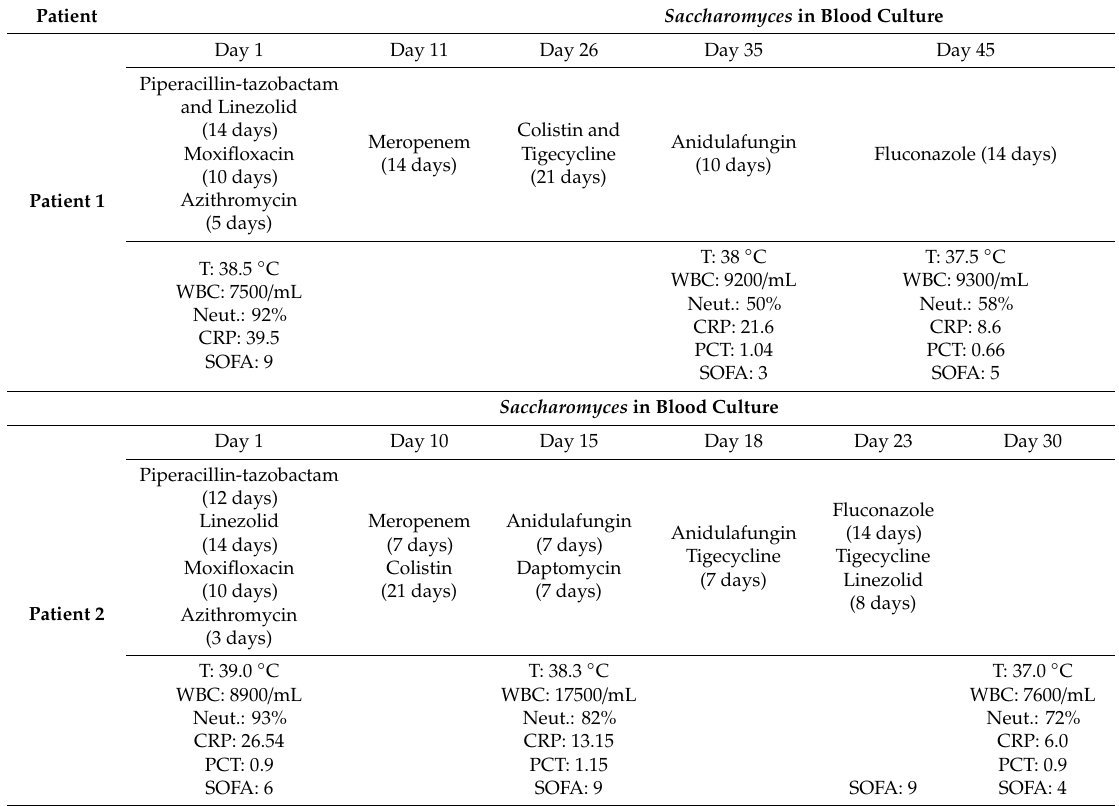
Table 1. Antimicrobials, duration of treatment, Sepsis-Related Organ Failure Assessment scores (SOFA scores), laboratory values and fever on indicative